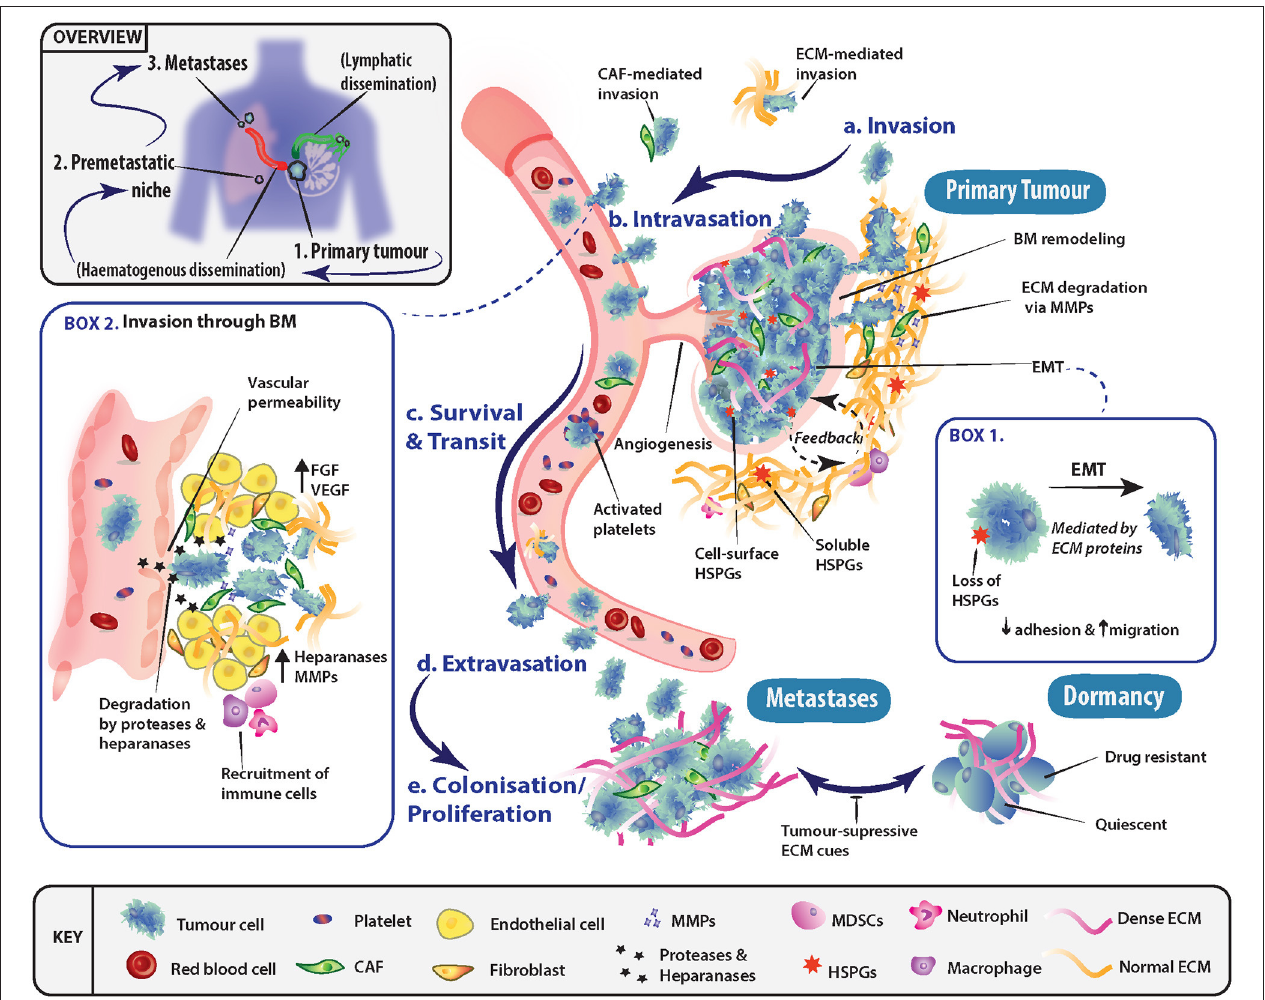
FIGURE 1 | Role of the extracellular matrix in driving progression through stages of the metastatic cascade. (a) Primary tumor cells may undergo epithelial-mesenchymal transition (EMT) (Box 1) and invade through basement membranes (BM) into the surrounding stroma. Tumor cell local invasion and metastatic dissemination is often facilitated by cancer-associated fibroblasts (CAFs) or specific ECM components, which may enhance invasion or modulate the immune system. (b) To disseminate to a secondary site, tumor cells must access the vascular system and intravasate through the endothelial BM. This occurs in part through the release of proteases and heparanase, which disrupt BM integrity (Box 2). (c) The circulating tumor cells (CTCs) must then survive transit to secondary sites of metastasis and can be assisted by platelet activation as well as accompanying CAFs. (d) To exit the vessel, cells extravasate into the surrounding tissue and seed at distinctly different tissues from the primary tumor. Overt colonization of secondary sites by disseminating tumor cells (DTCs) is greatly enhanced through extravasation at premetastatic niches. (e) Extravasated cancer cells typically have three fates, either colonize and proliferate to form overt metastases, enter a reversible state of dormancy or, in most cases,